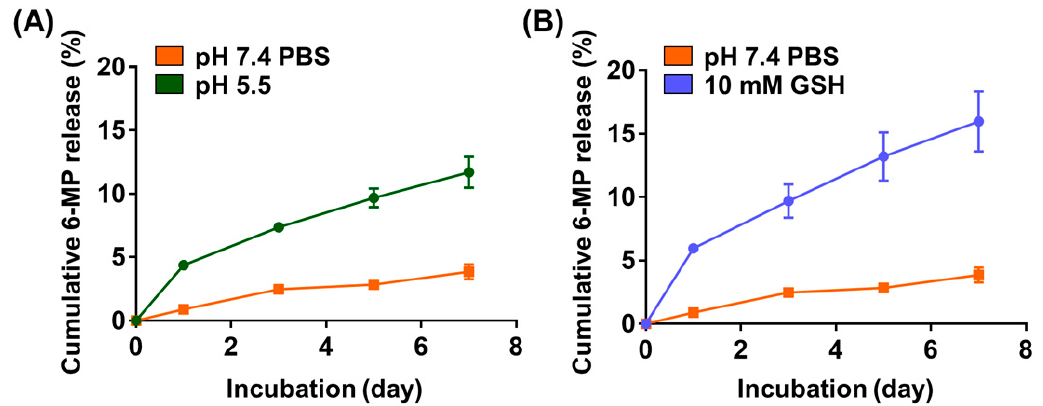
Figure 5. % cumulative 6-MP release profile at ( A ) different pH and ( B ) glutathione concentra- tions.